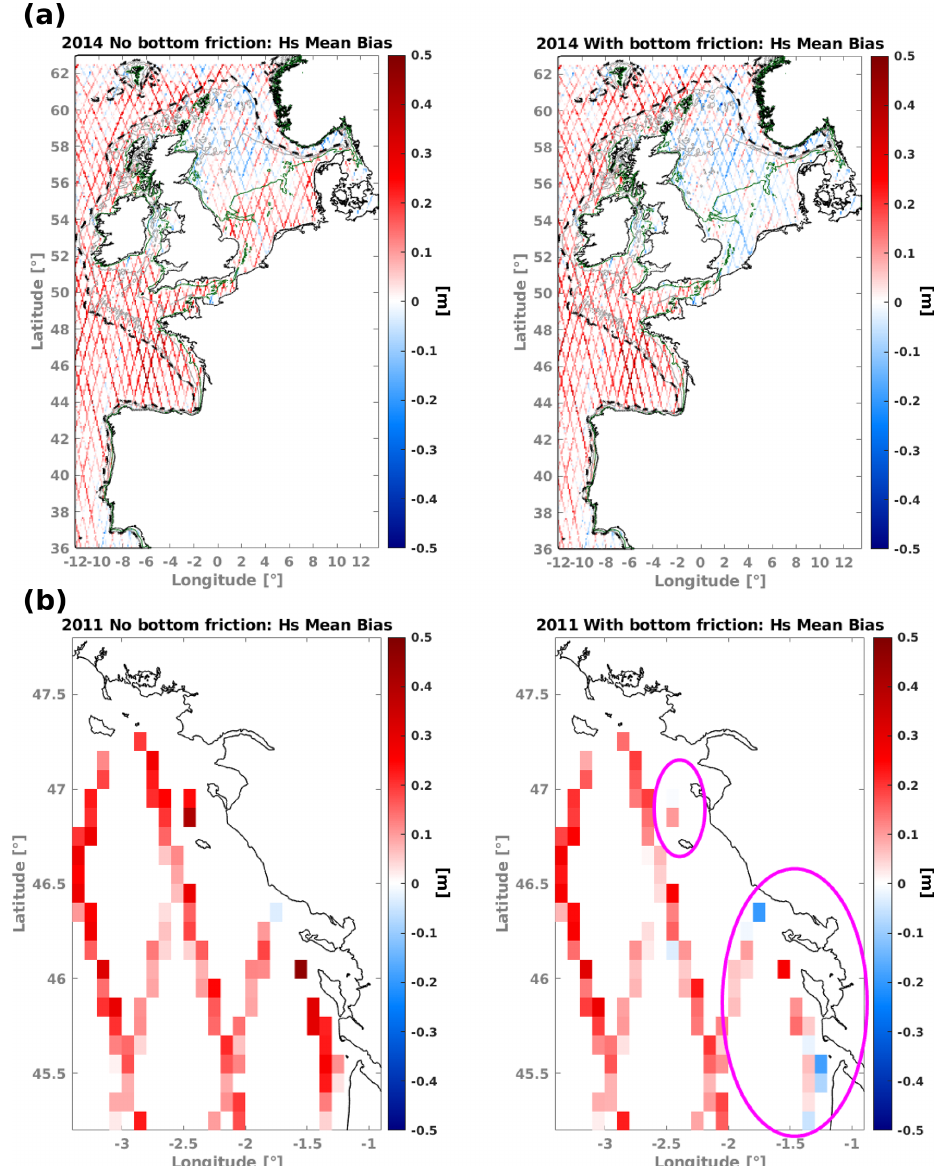
Figure 14. Wave height bias (WW3 – altimeter) computed with (a) Saral for the year 2014 and (b) Envisat for the year 2011. Dashed black lines show the 200m depth contour, green lines the 50m depth contours, and gray lines depth contours from 100 to 150m depth. Magenta ovals in (b) highlight areas with the largest bias